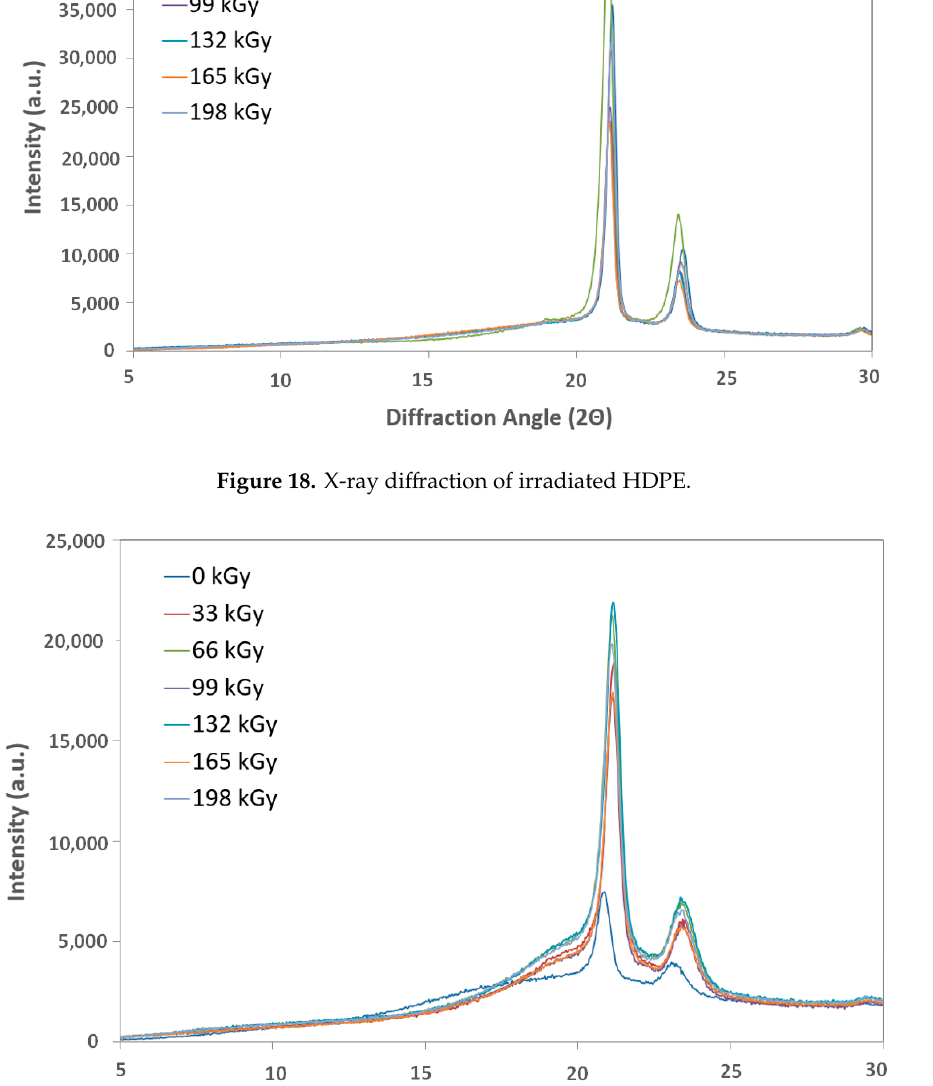
Figure 20. X-ray diffraction crystallinity of irradiated LDPE and HDPE; the vertical line drawn at the top of the column represents the standard deviation. 4. Conclusions The ionizing beta radiation results indicated a positive effect on the tested materials’ nano- mechanical properties. The LDPE and HDPE property changes differed with increasing radiation dosages. Polyolefin polymer representative materials are often used in technical practice. HDPE and LDPE were the representative polymers. Electron radiation induced the creation of a 3D network within the selected polymers’ structures, and thus significantly altered the polymers’ final behavior.